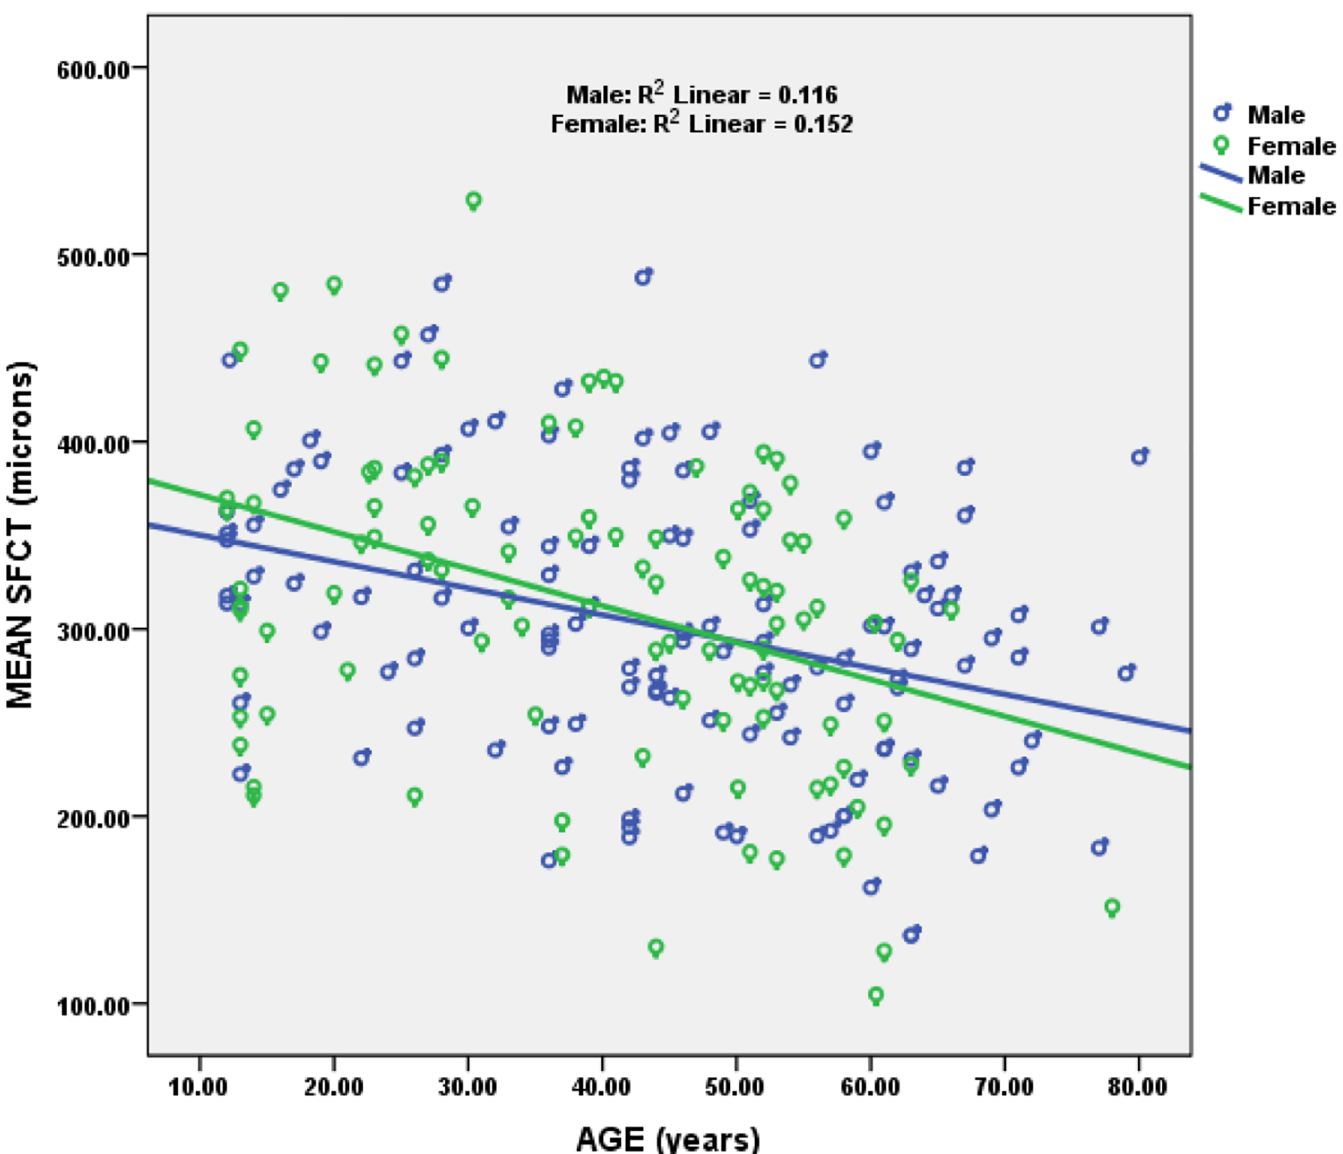
Fig 4. Scatter plot showing negative correlation between SFCT and